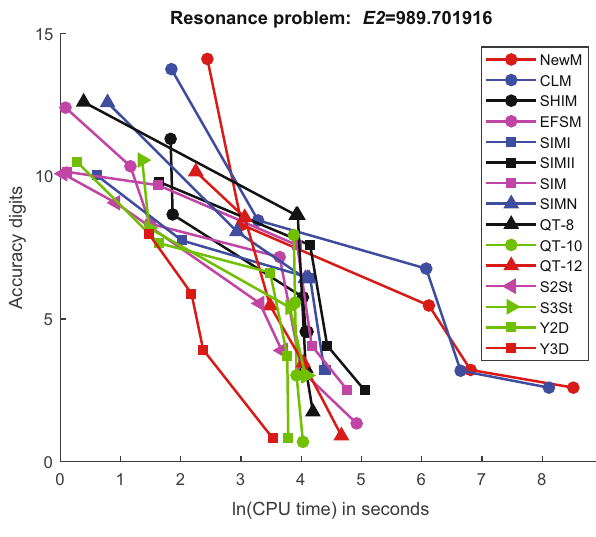
Figure 7: Methods e ffi ciency using E 989.701916 2 =